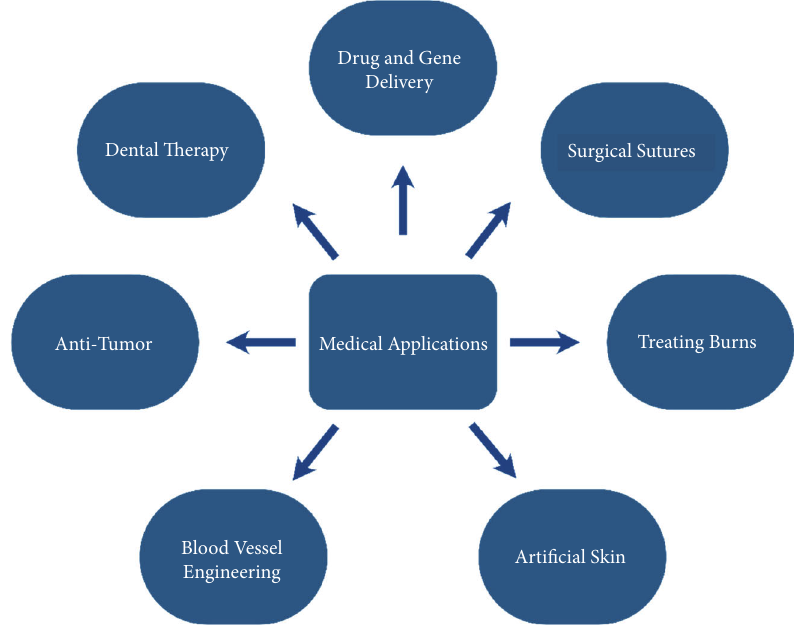
Figure 3: Medical applications of chitosan-based